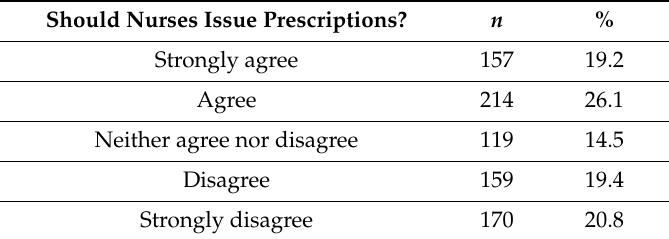
Table 3. Distribution of answers to the question “Should nurses issue prescriptions?” n =